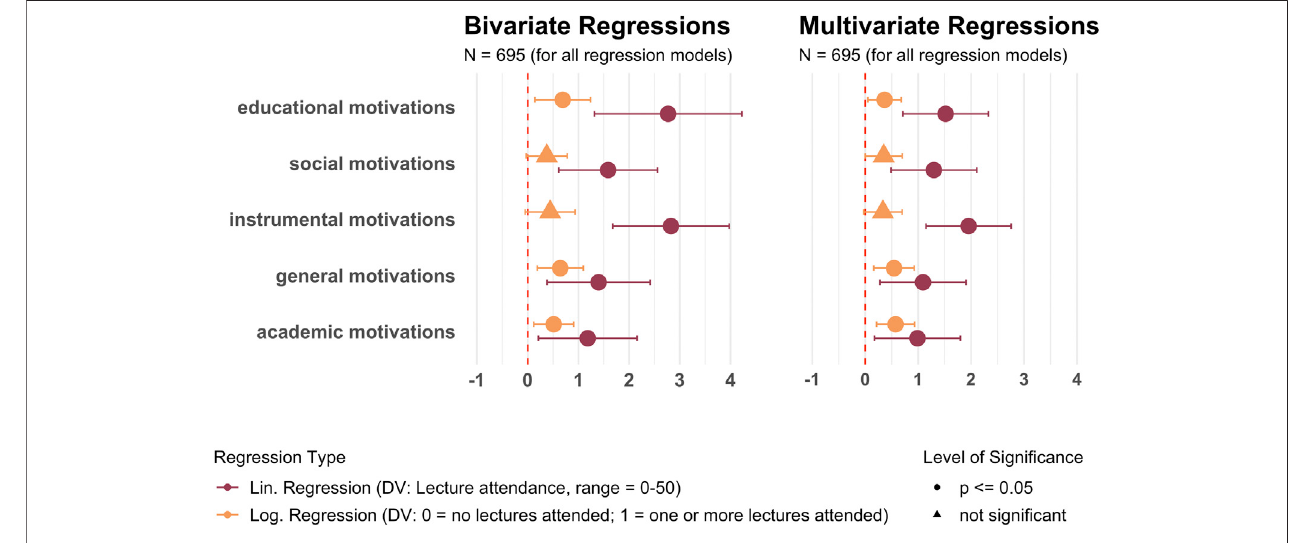
FIGURE 1 | Plot of the bi- and multivariate regressions.